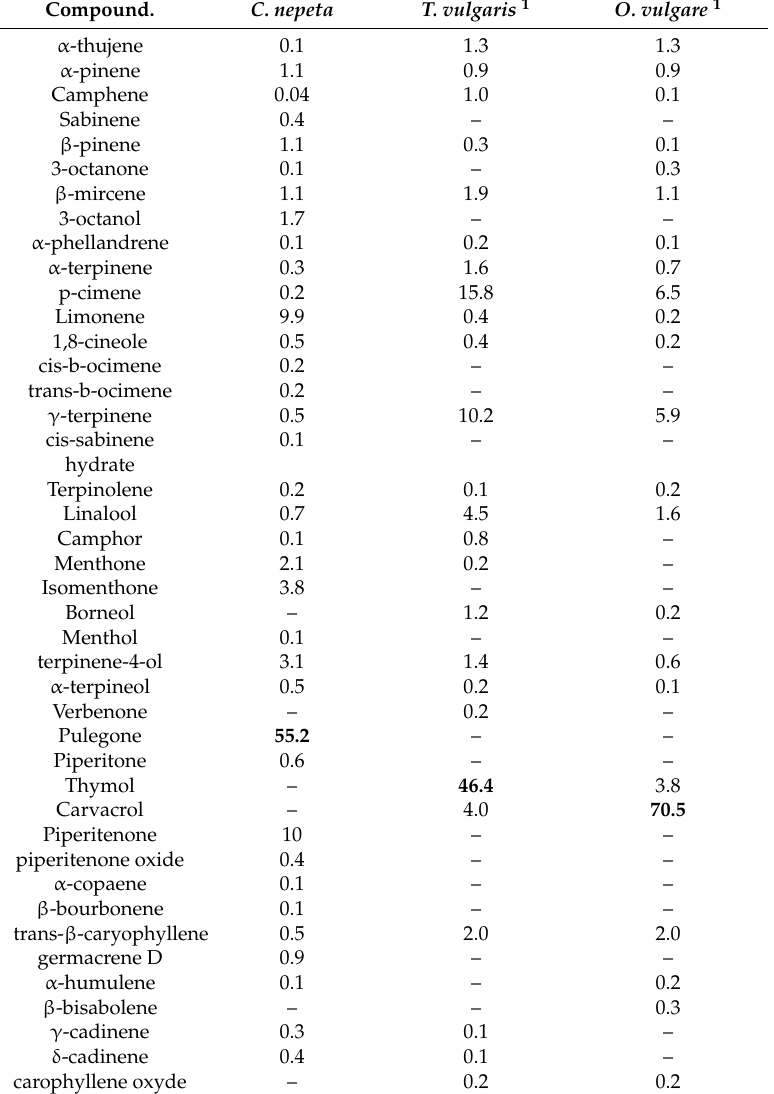
Table 1. Chemical characterization and chromatographic area percentage of the compounds present in the essential oils (EOs). Minor compounds (concentration < 0.02%) have not been included. The concentrations in percentage of the active principles are indicated in